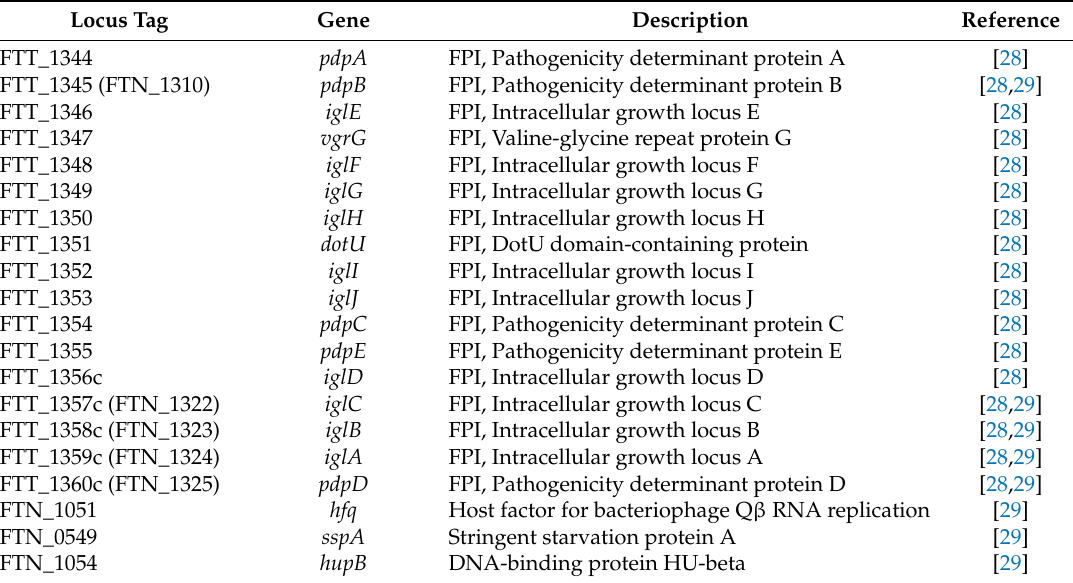
Table 2. Genes that are associated with Francisella tularensis or Francisella novicida virulence and are positively regulated by macrophage growth locus, subunit A